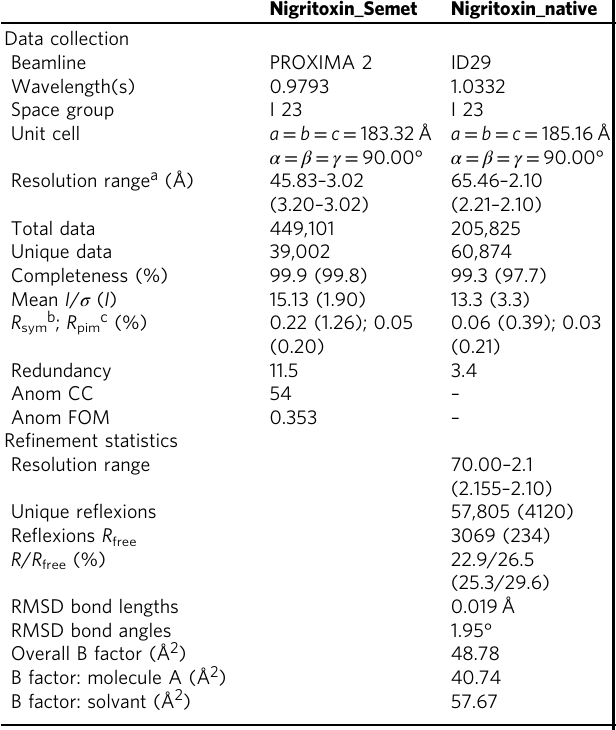
REFMAC5 44 , and model building with COOT 45 to construct the missing parts. Further data collection and re fi nement statistics are provided in Table 1. To compare the folding state of the different mutant forms of nigritoxin, the polydispersity and hydrodynamic particle radius of the heterologously (and solubly) expressed proteins were measured by dynamic light scattering (Malvern Zetasizer). The wild-type protein showed no aggregation at all and the